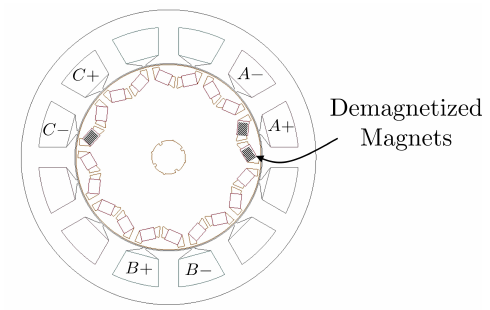
Figure 8. Demagnetized